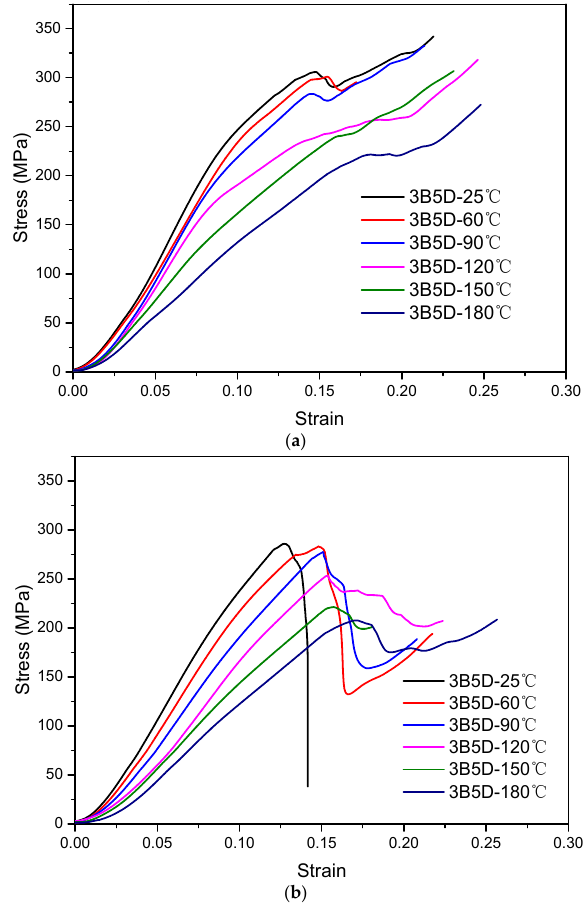
Figure 5. Compression stress versus strain curves of composites at di ff erent temperatures. ( a ) Specimens with braiding angle of 21 ◦ . ( b ) Specimens with braiding angle of 32 ◦